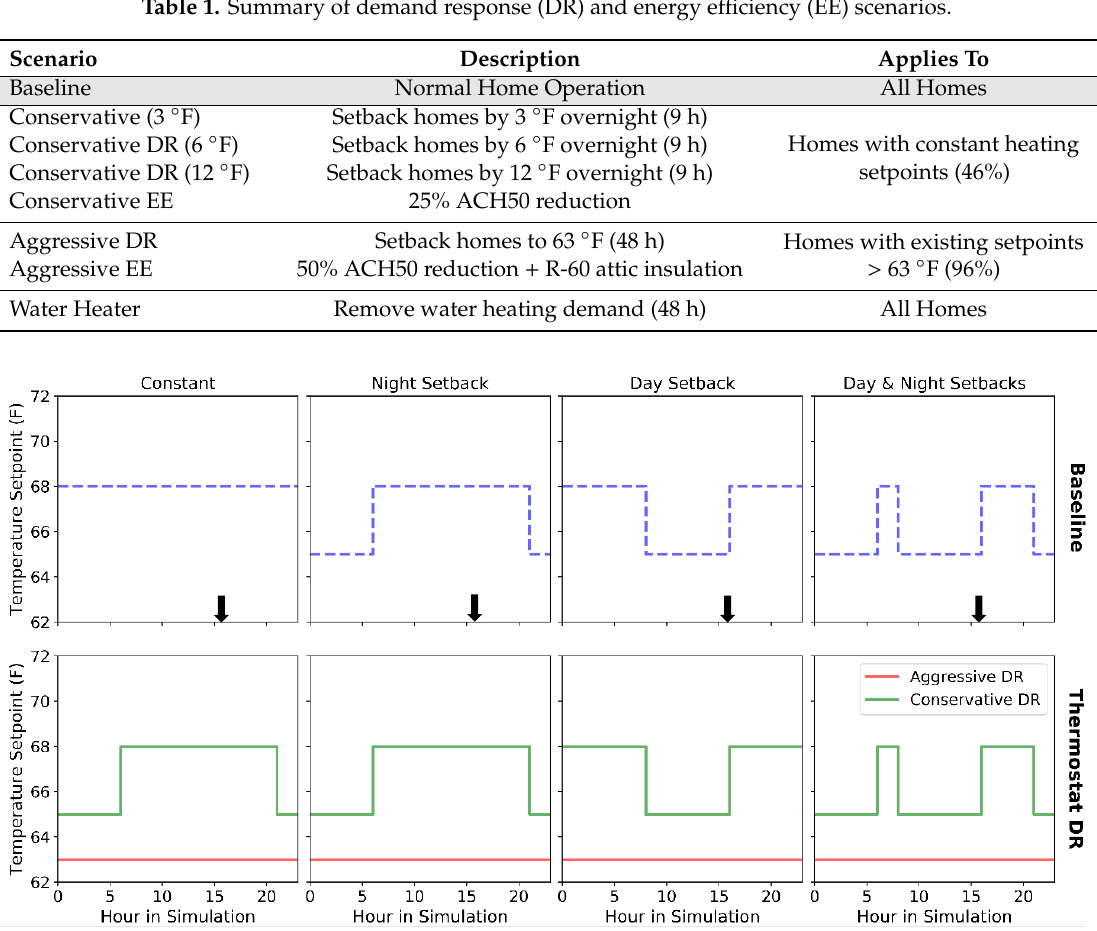
Figure 4. Example thermostat schedules for the baseline operation ( top ) and the resulting schedule after thermostat demand response ( bottom ).